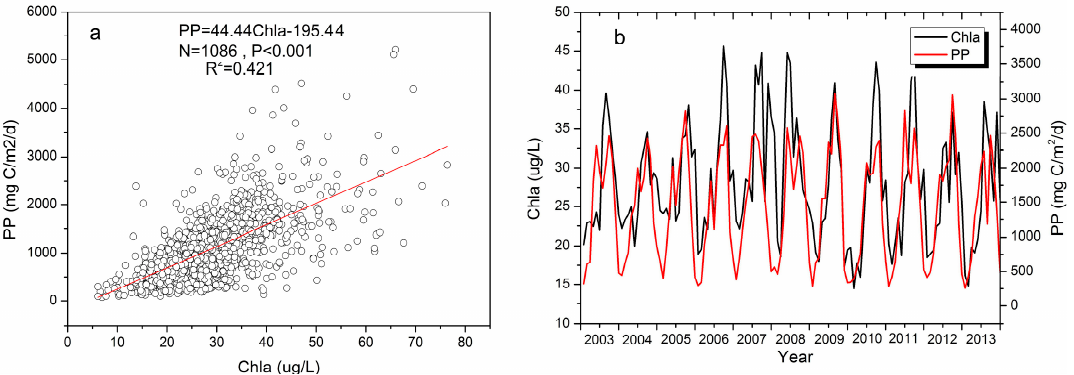
Figure 8. ( a ) Relationship between Chl a and MODIS derived primary productivity of Lake Taihu from 2003–2013 ( b ) Monthly mean MODIS derived primary productivity and Chl a of Lake Taihu from 2003–2013.